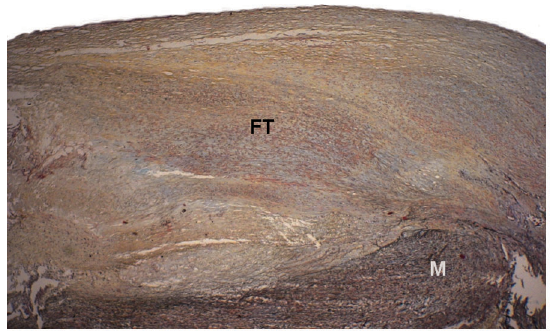
Figure 3. Cross section depicting an advanced lesion type Vc. Movats staining, magnification 20 6 . No lipid core. The lesion basically consists of fibrous connective tissue (FT) with yellow staining of collagen fibers and red-colored smooth muscle cells. M: Media.